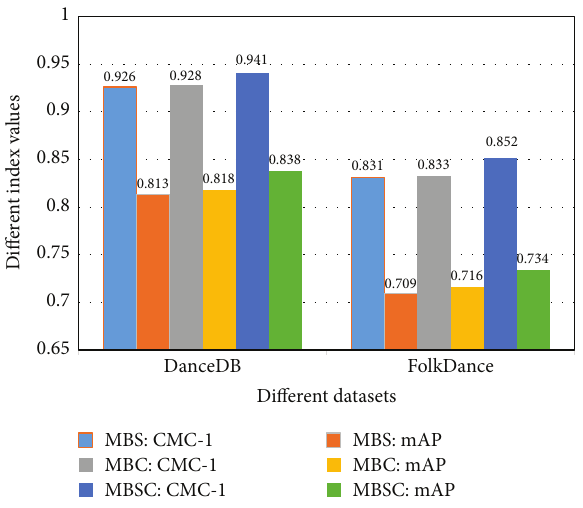
Figure 8: Ablation